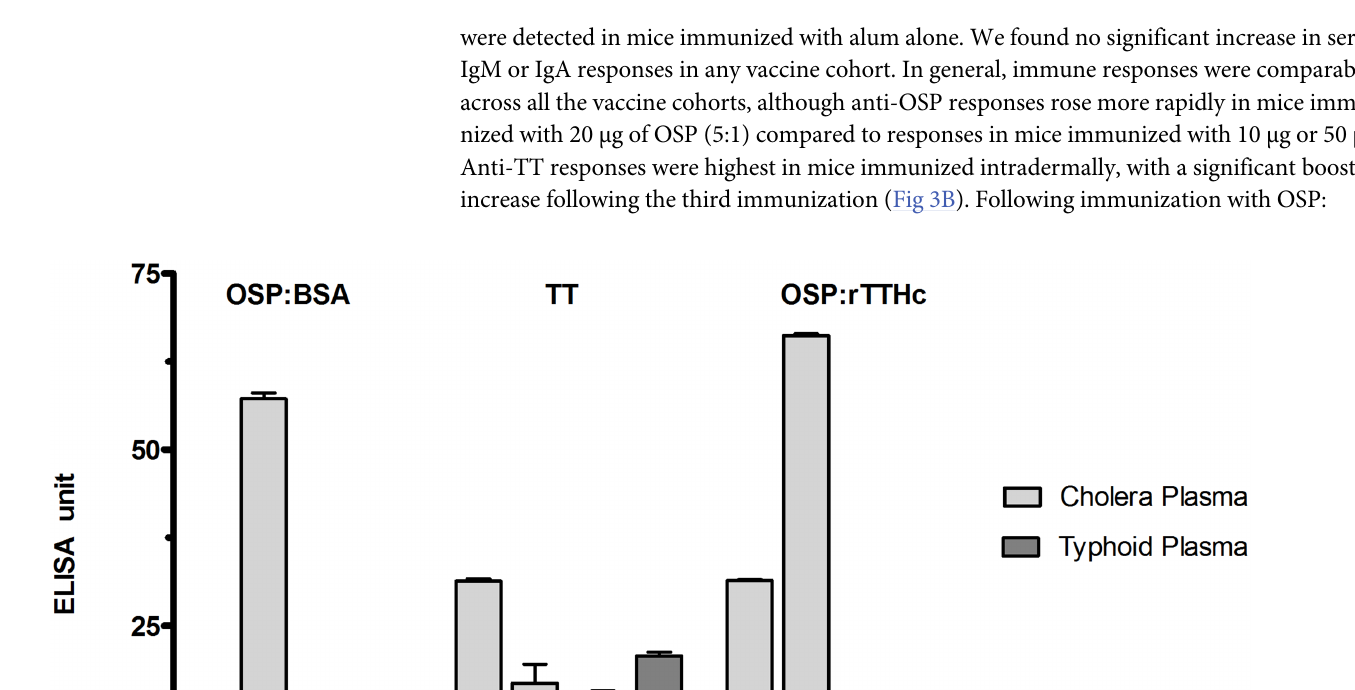
Fig 1. Structure of Inaba OSP:rTTHc conjugate. Variations of conjugates containing 3, 5, or 10 moles of OSP per mole carrier were developed. rTTHc = recombinant tetanus toxoid heavy chain fragment.